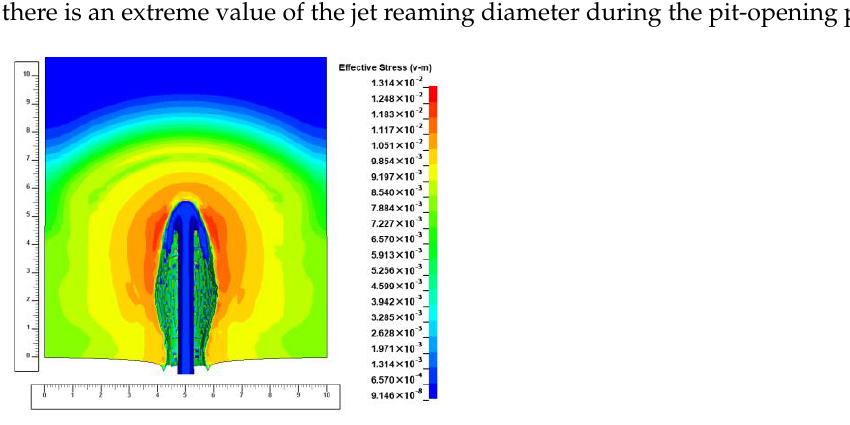
Figure 5. Schematic diagram of the jet aperture at the later stages of the pit-opening.